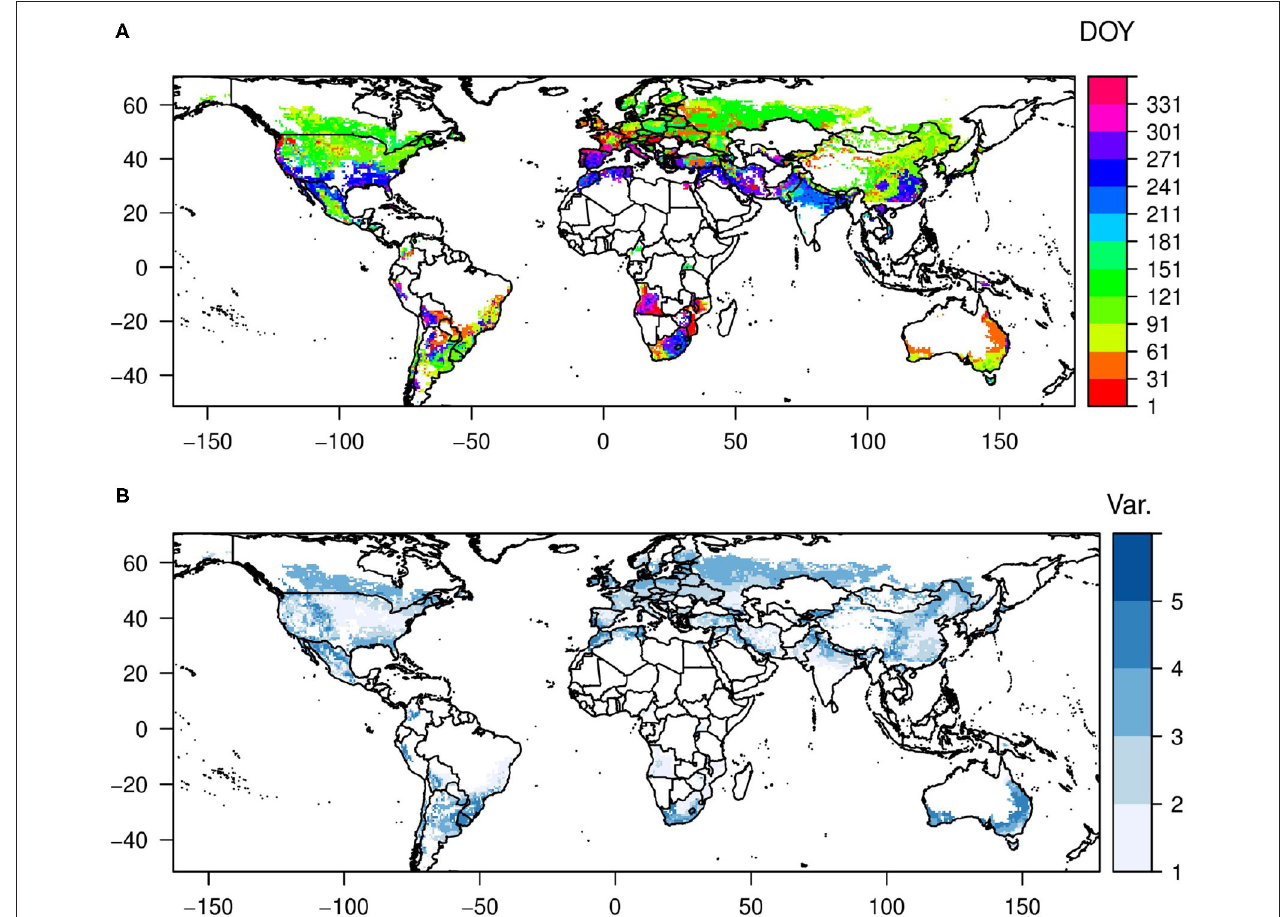
FIGURE 7 | (A) Start of the planting window. (B) Varieties chosen for 2040–2060 using the HadGEM2-ES